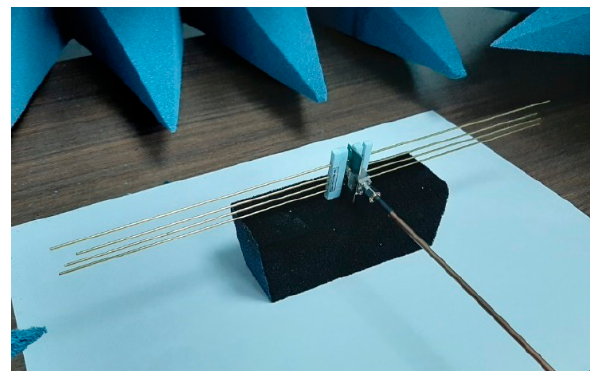
Figure 9. Antenna prototype based on the characteristics of the antenna solution #6 (Table 2) and built following the geometrical descriptions of Table 4 used as a proof-of-concept device for testing the hypothesis of this work.